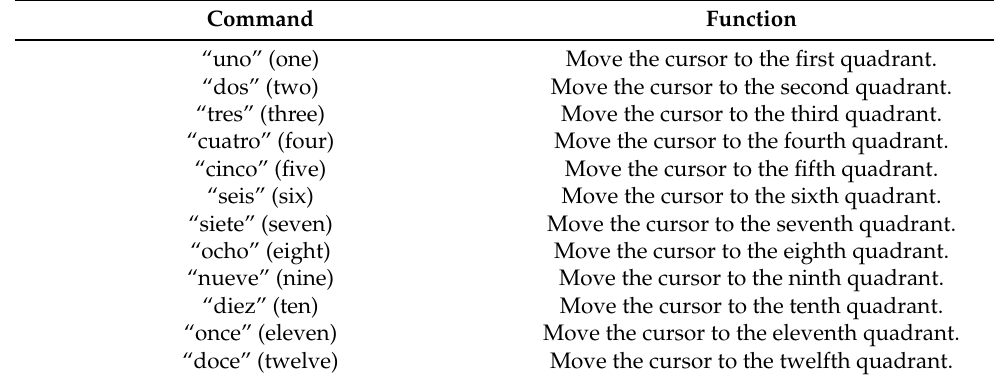
Table 2. EMKEY predefined control